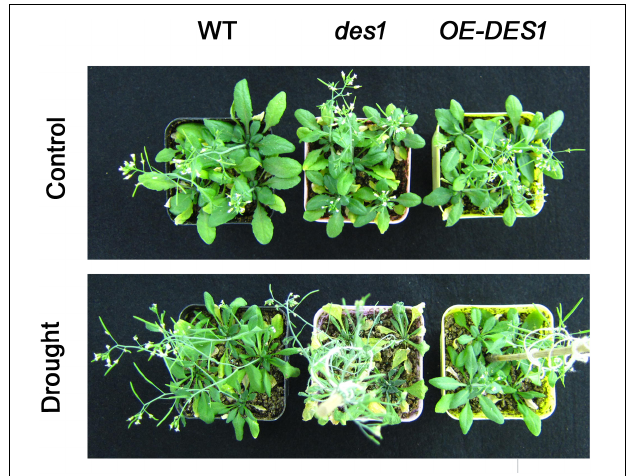
FIGURE 1 | Effects of endogenous H 2 S on seedling growth. The 4-week-old WT, des1 and OE-DES1 seedlings were subjected to drought stress by withholding water for 7 days, and then the growth states of seedlings were